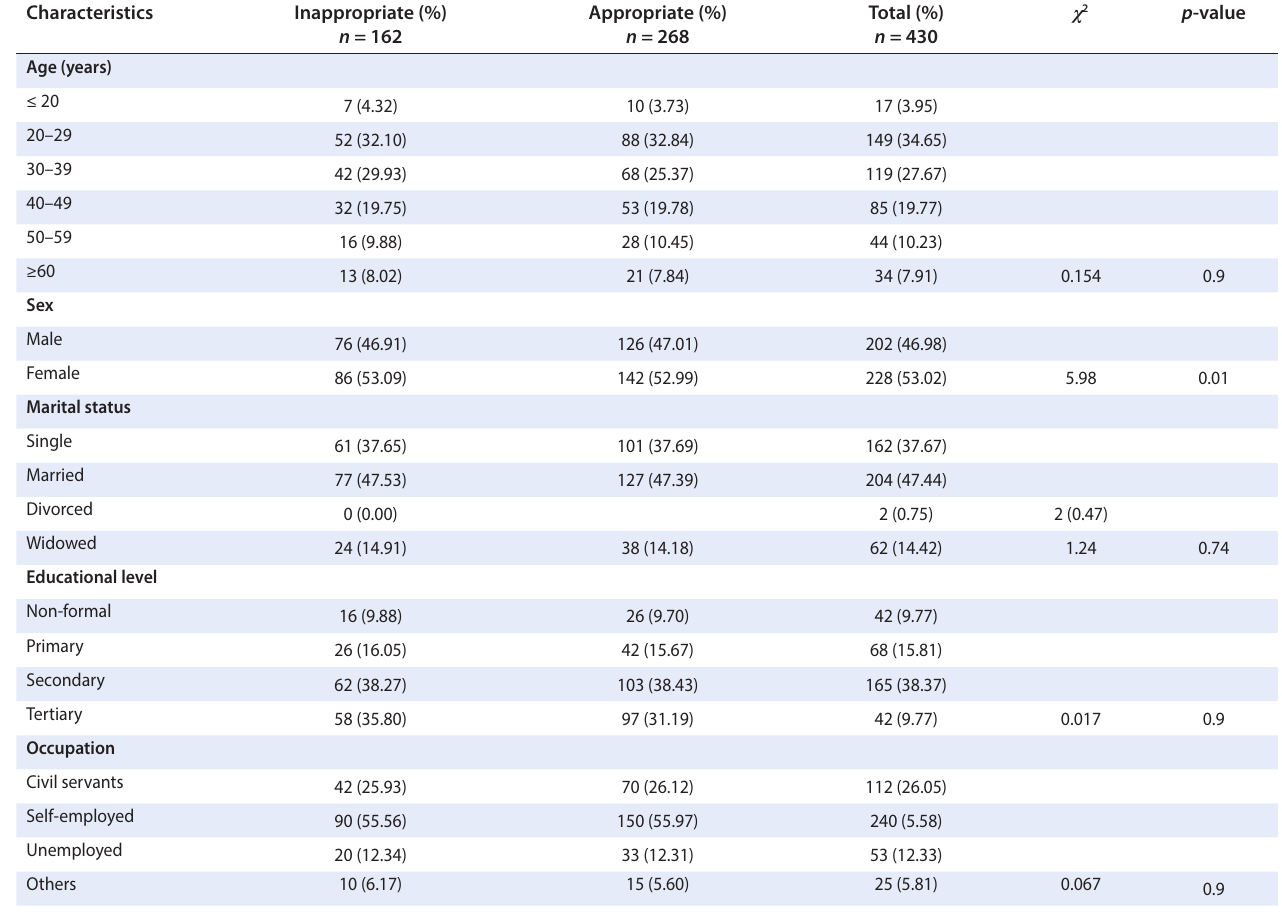
Table 1: Socio-demographic characteristics of patients attending AED Characteristics